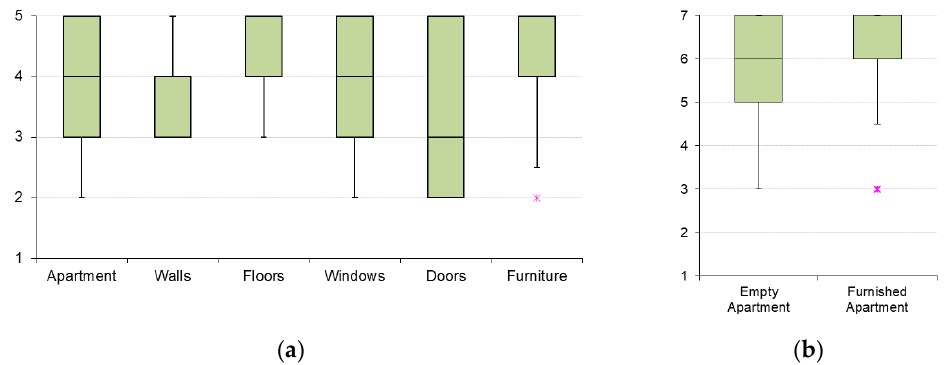
Figure 20. ( a ) Individual parts of the VR environment in relation to the rated visual appearance. ( b ) Results of the presence questionnaire for both VR scenarios.